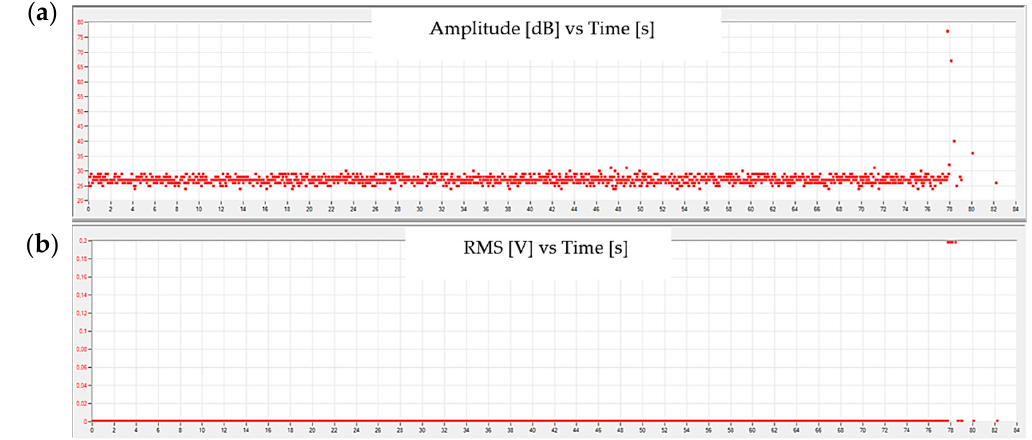
Figure 6. Sample graphs showing the change in ( a ) amplitude and ( b ) RMS of the signal as a function of time for a pure resin sample.